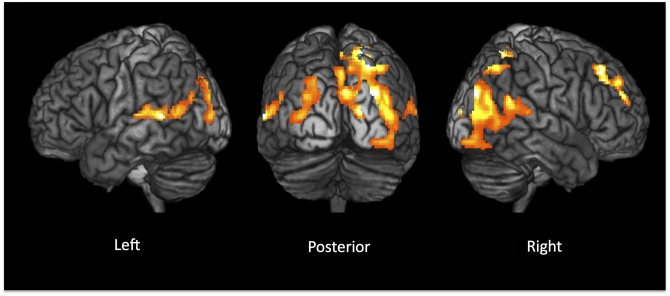
VBM analysis: PCA patients compared to healthy controls showed a widespread pattern of bilateral grey matter loss, predominantly affecting the posterior areas of the brain.The opposite contrast (PCA patients more than controls) did not reveal any significant difference. Statistical threshold: p<0.05 Family Wise Error (FWE) corrected at cluster level. See text for further details.